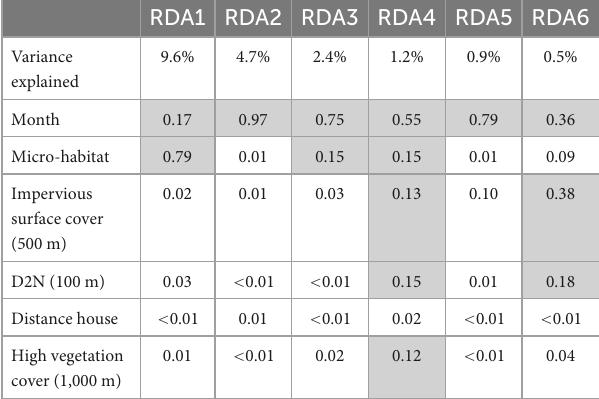
TABLE 2 Correlation between RDA components and selected explanatory